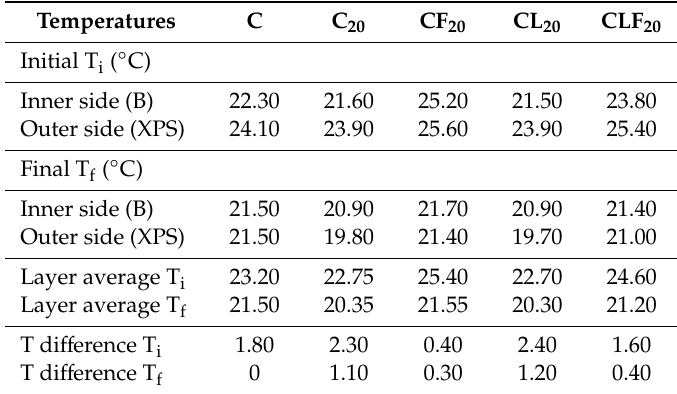
Table 4. Temperatures on both sides of the PCM cement-lime mortar layer measured inside the enclosure during the cooling cycle (from 30 ◦ C to 15 ◦